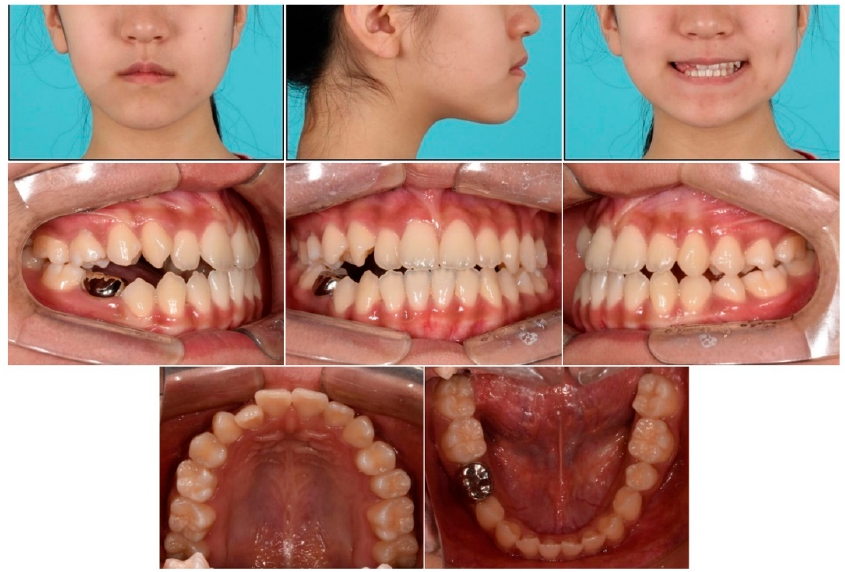
Figure 1. Pretreatment facial and intraoral photographs.